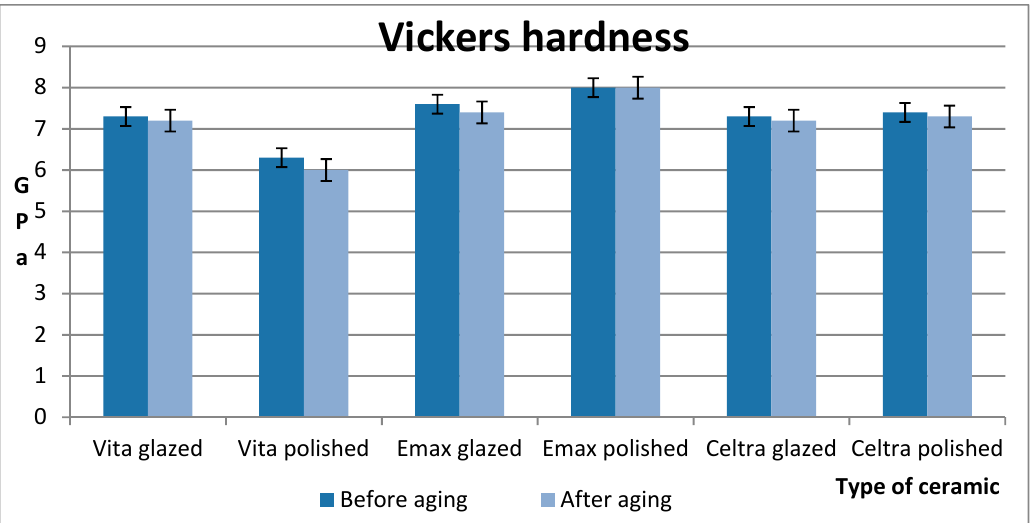
Figure 7. Vickers hardness of materials before and after thermocycling.